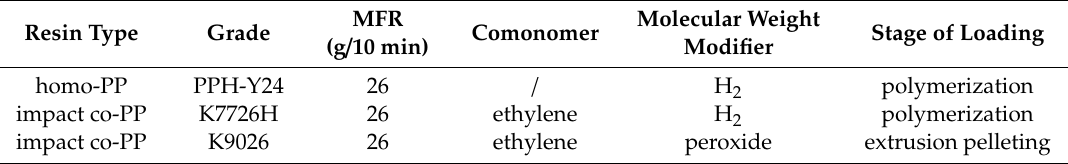
Table 3. Composition and properties of three grades of PP resins used in the